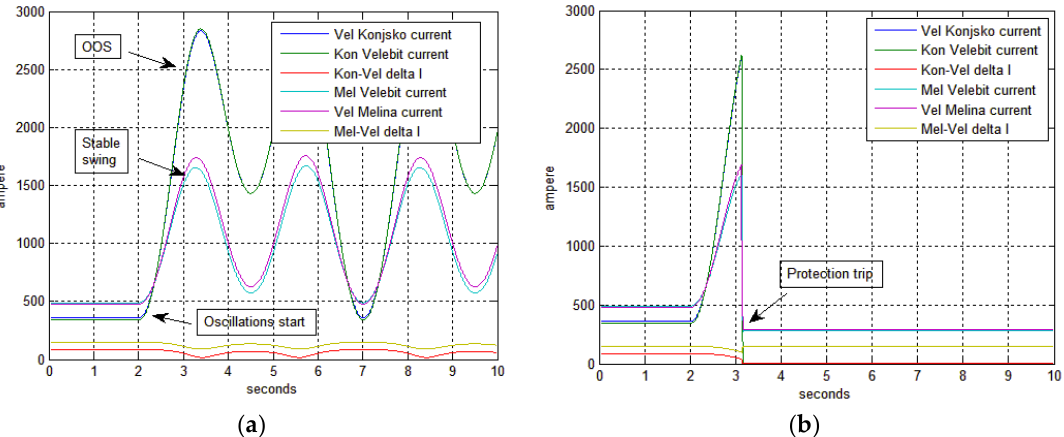
Figure 17. Remedial line protection criteria: ( a ) Konjsko-Velebit and Melina-Velebit currents from both line ends with differential current protection (Δ I ). Out-of-step has developed on Konjsko-Velebit line and only stable power swing was present on Melina-Velebit line; ( b ) Konjsko-Velebit and Melina-Velebit transmission line current with protection operations.